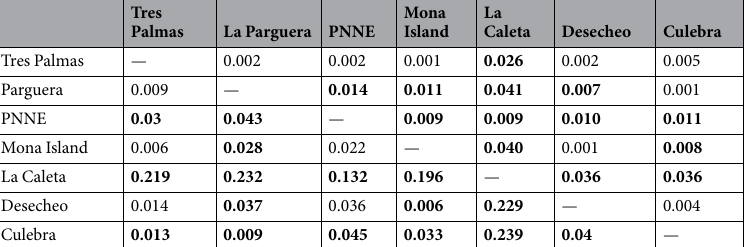
Table 1. Spatial genetic structure ( F ST ) across the Mona Passage as derived from 12 microsatellites (above diagonal) and 10,047 SNPs (below diagonal). Alpha values were adjusted with a Bonferroni correction (0.05/21 = 0.023). Significantly different pairwise comparisons are shown in bold (p <